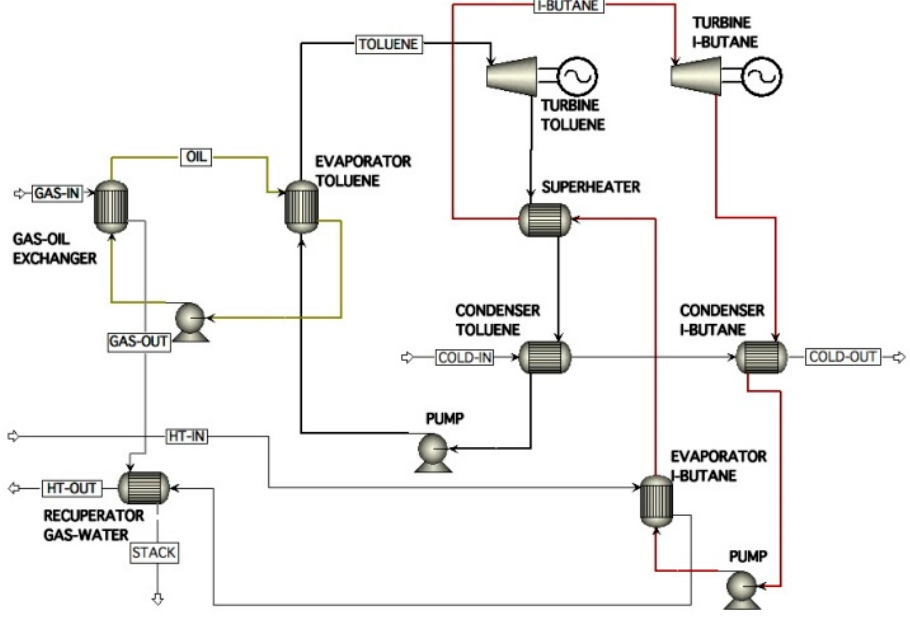
Figure 9. Combined ORC cycles with two temperature levels.